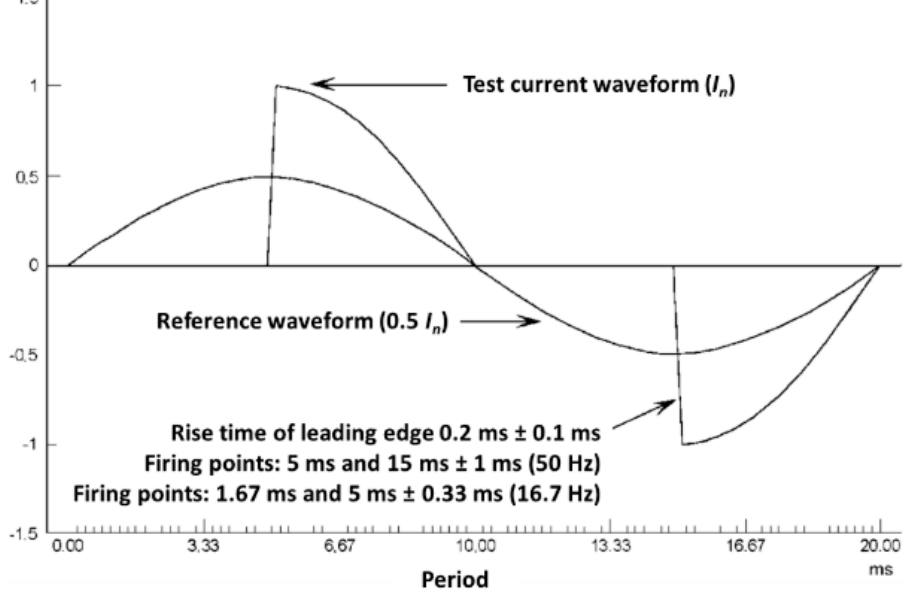
Figure 12. Phase-fired current waveform (90°).